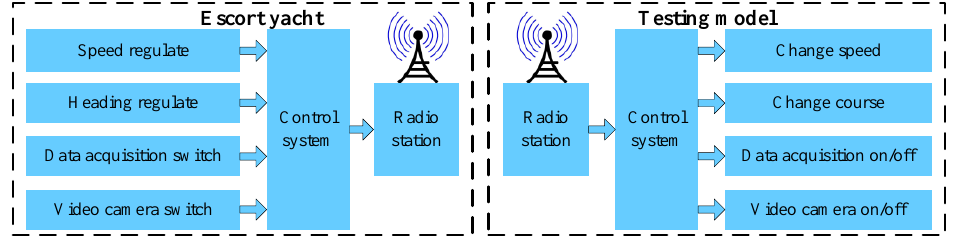
Figure 22. Framework of the remote control system.